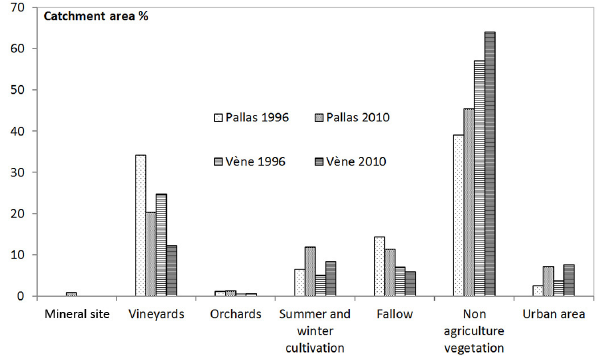
Figure 2. Land use distribution in the Vène and in the Pallas water- sheds for 1996 and